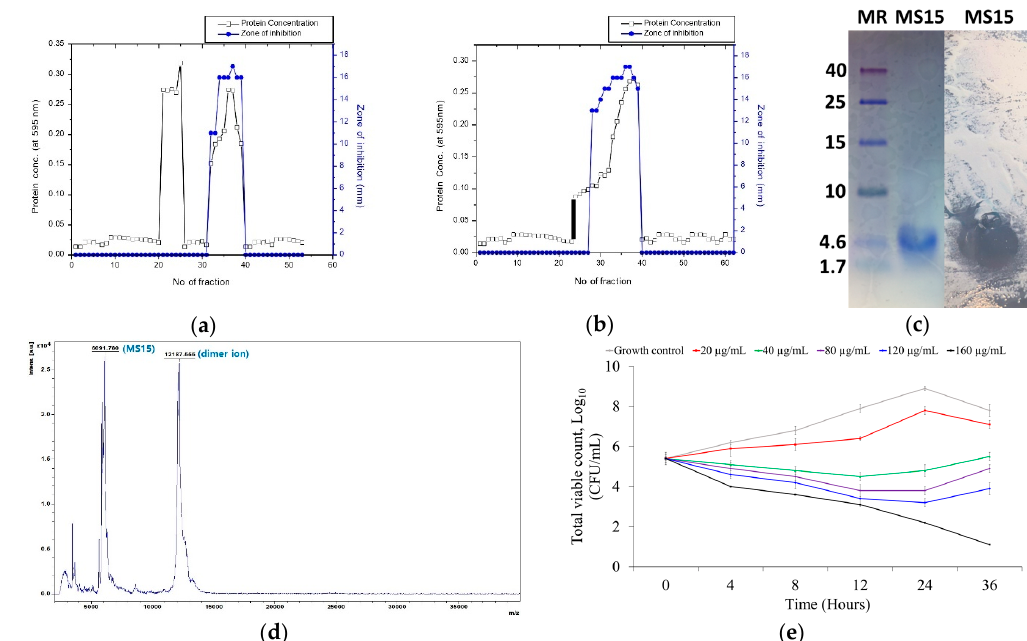
Figure 3 . The elution profile of peptide MS15 from ( a ) the Sephadex G-50 column (3 × 90 cm) and ( b ) the DEAE Sephadex A-50 column (1.2 × 35 cm) . ( c ) Tricine SDS-PAGE gel electrophoresis and DEAE Sephadex A-50 column (1.2 × 35 cm). ( c ) Tricine SDS-PAGE gel electrophoresis and